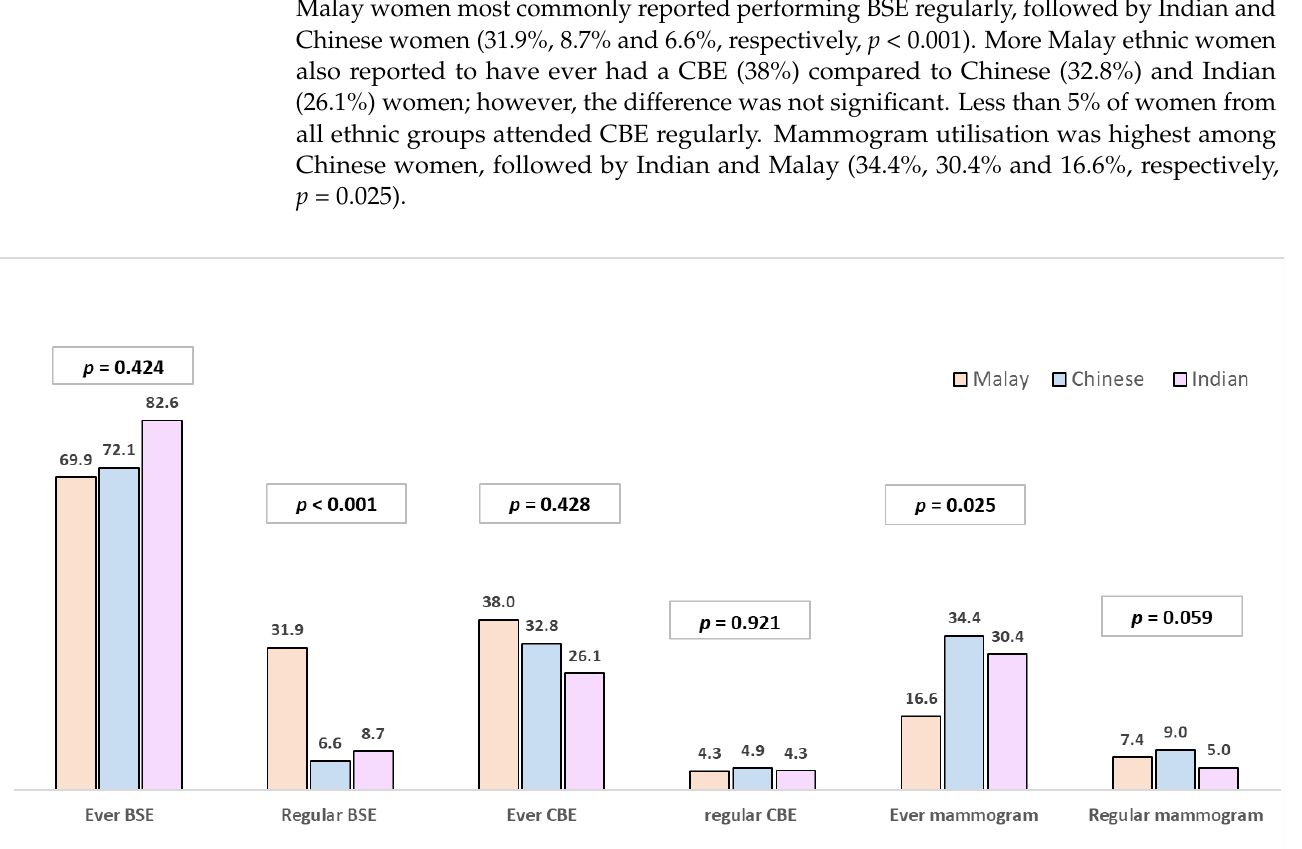
Figure 1. Breast cancer screening practices among women from different ethnic groups (percentage), n : Malay = 163, Chinese = 61, Indian = 23; p values reported for chi-square test comparing the three ethnic groups.